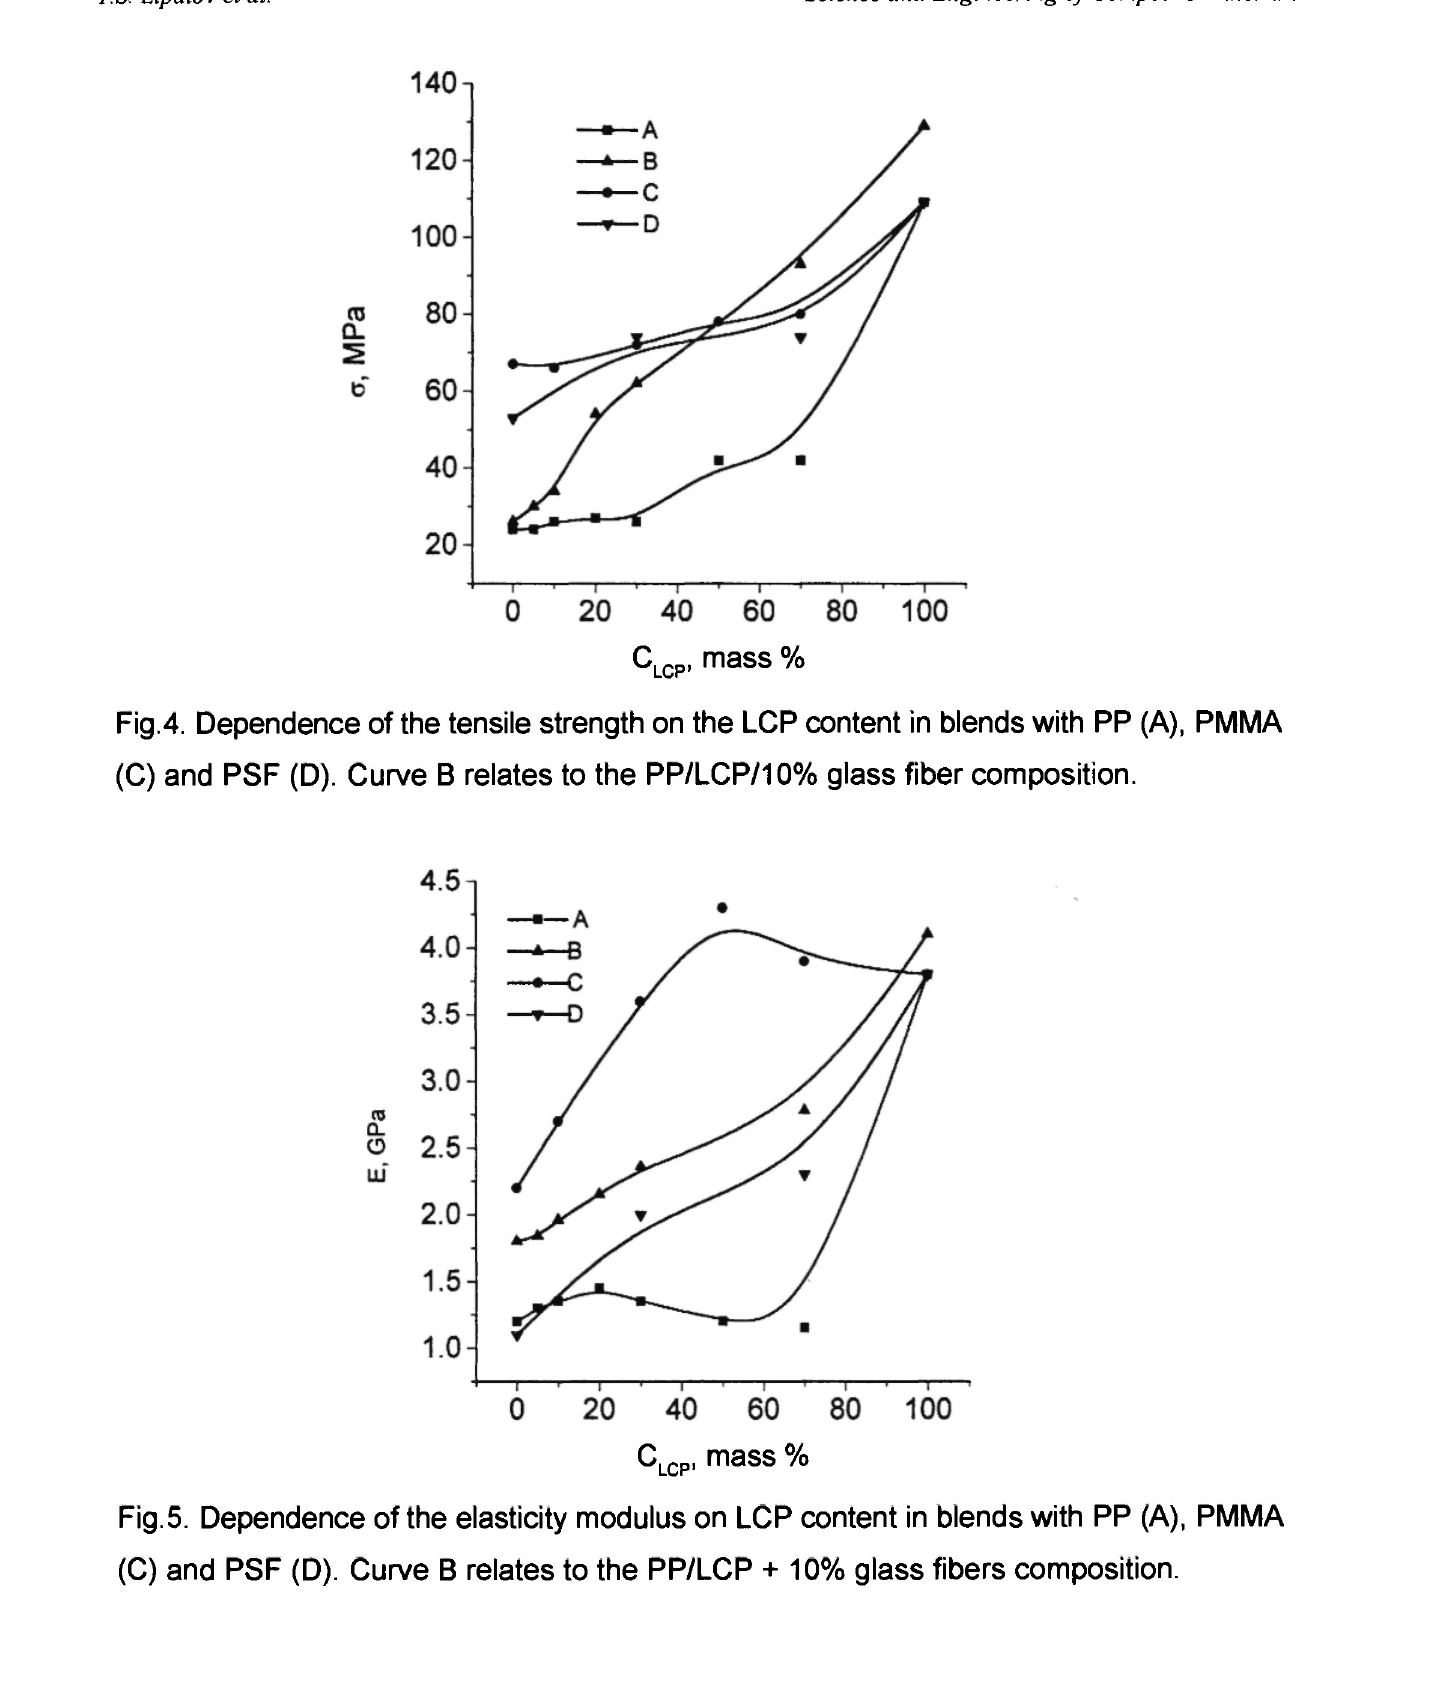
Fig.5. Dependence of the elasticity modulus on LCP content in blends with PP (A), PMMA (C) and PSF (D). Curve Β relates to the PP/LCP + 10% glass fibers